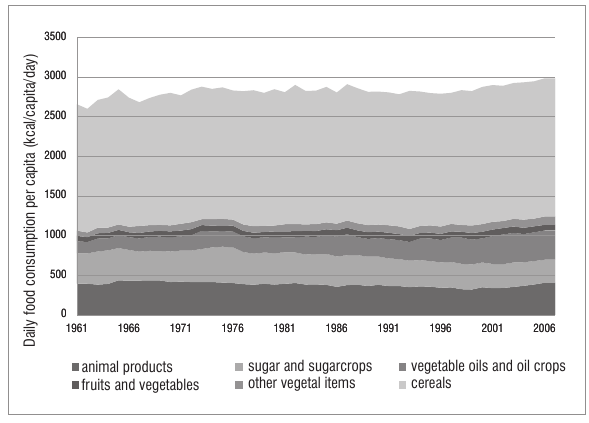
Figure 2: Changes in food consumption in South Africa from 1961 to 2007 divided into six main